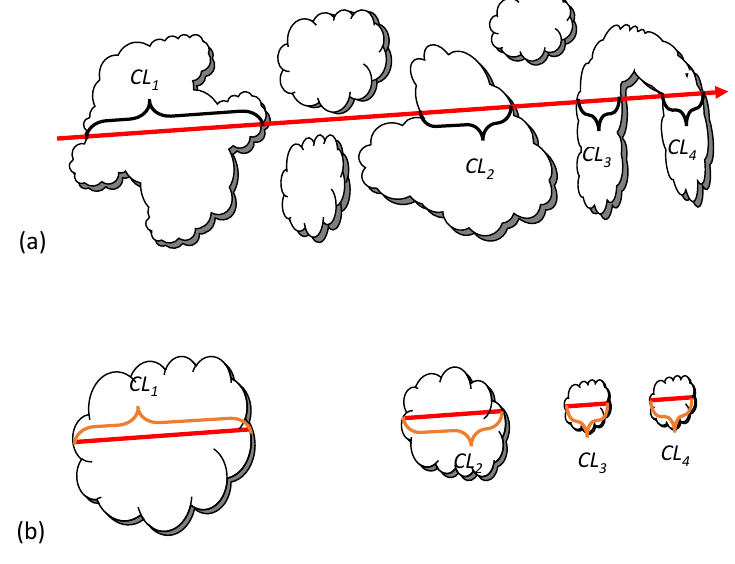
Figure 1. Illustration of potential biases in the chord length distribution. ( a ) A linear observation through a cloud field. ( b ) A naïve interpretation of the cloud field based on those chord